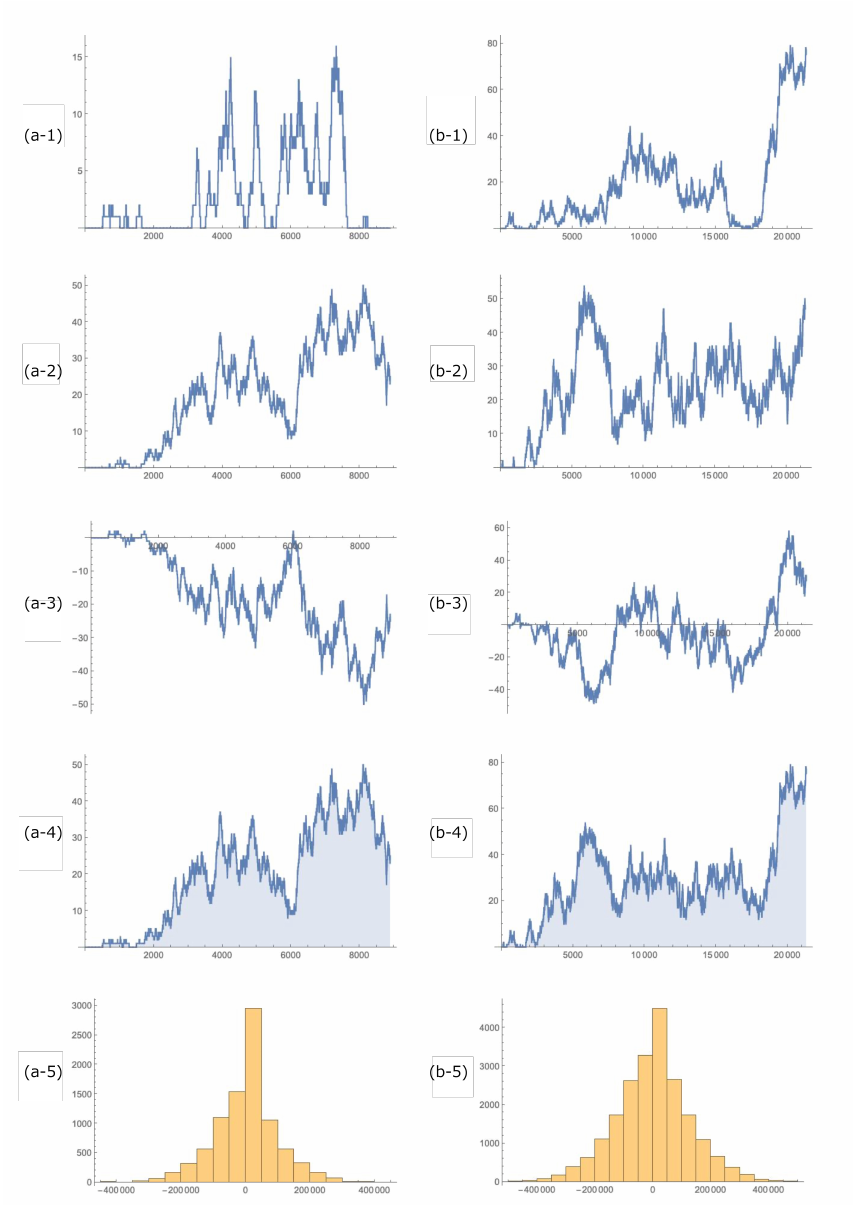
Figure 5. Results of Markov chain simulation. ( a ) TOPIX, ( b ) USD/JPY, (1) Numbers of buying shares, (2) Numbers of selling shares, (3) Prices, (4) Trading Volumes, and (5) Distribution of